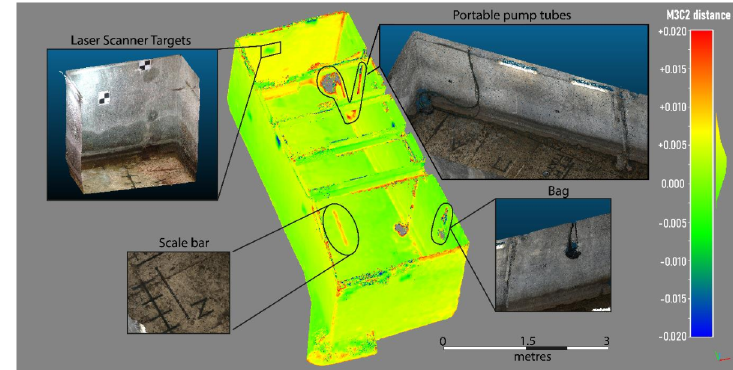
Figure 8. Comparison between two point